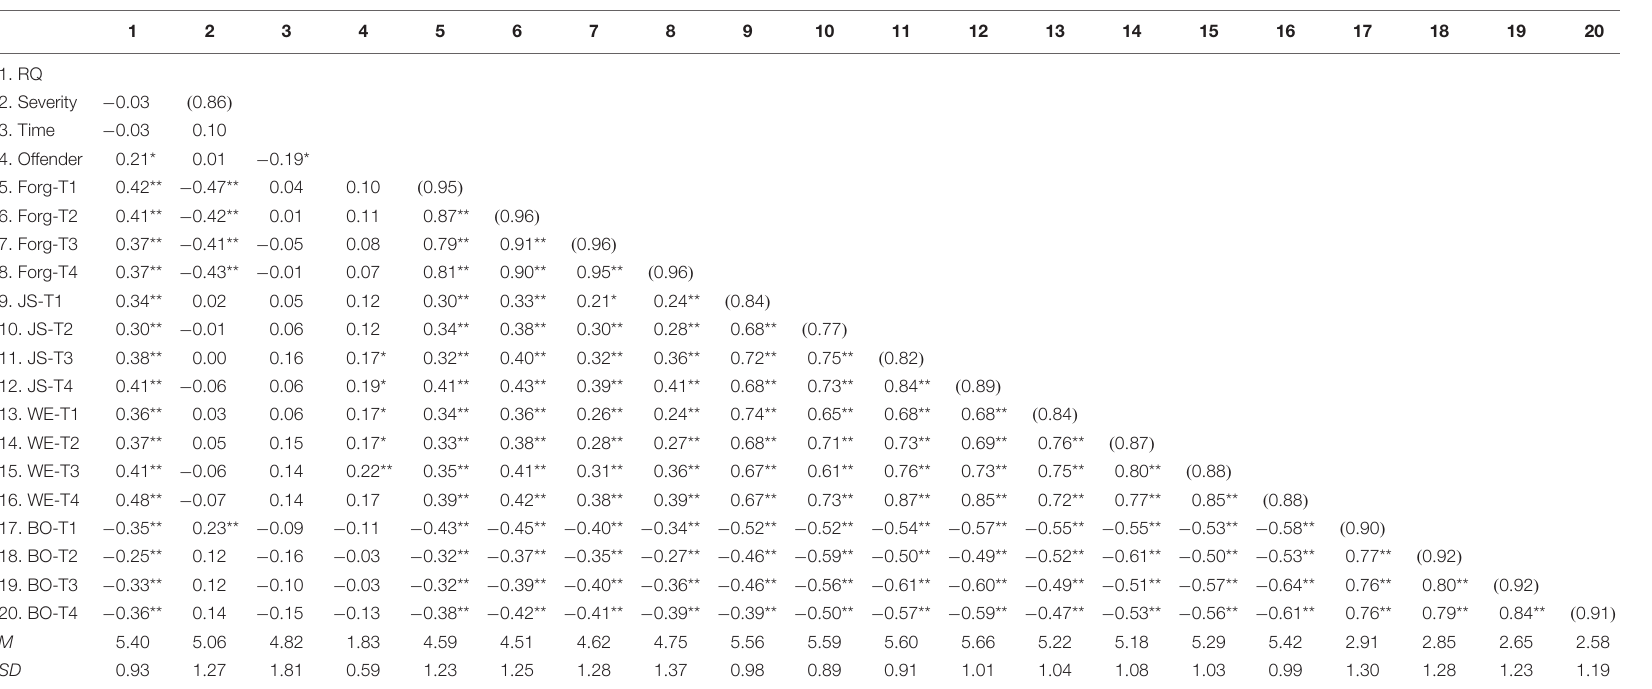
TABLE 2 | Descriptive statistics and correlations for main study